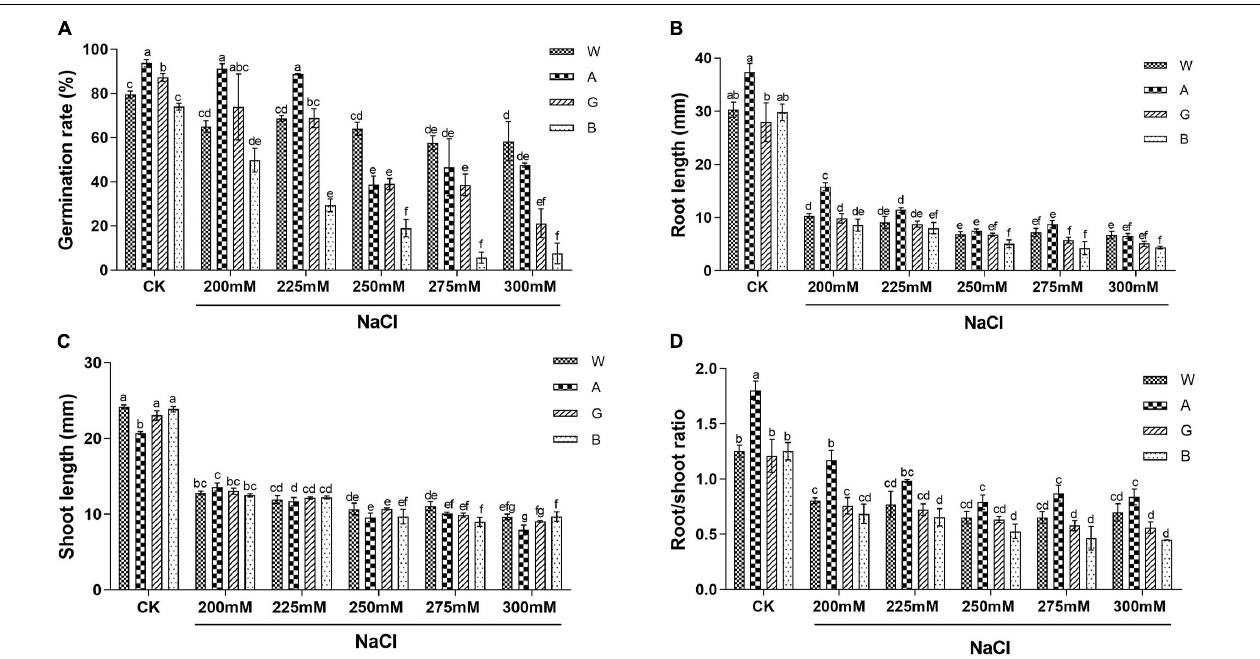
FIGURE 1 | Salt stress inhibited germination and the growth of different alfalfa varieties. CK: Water. NaCl: 200, 225, 250, 275, and 300 mM. For each replicate, one hundred alfalfa seeds were surface-sterilized, spread evenly on two layers of filter paper which were presoaked with 5 ml treatment solution, and placed in a Petri dish at 20 ◦ C in an illuminating incubator. (A) Germination rate. Germinated seeds were calculated on the 10th day and germination rates were determined. Four biological replicates were performed and error bars show the SE values. (B) Root length. (C) Shoot length. (D) Root/shoot ratio. n = 20–40. The t -test was performed between samples in different treatment groups. Different numbers indicated significant differences ( p (cid:53) 0.05) between different treatments. A, Algonquin; B, Bingchi; G, Golden Empress; W,